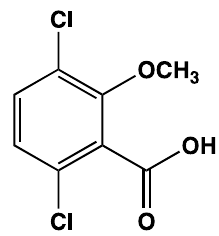
Figure 1. Chemical structure of dicamba.